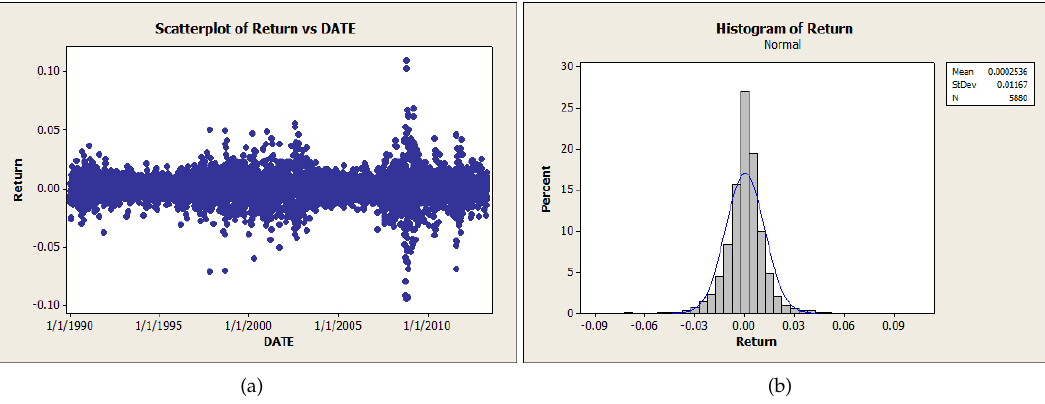
Figure 1. Market Data. ( a ) daily Returns; ( b ) histogram of Return Data.